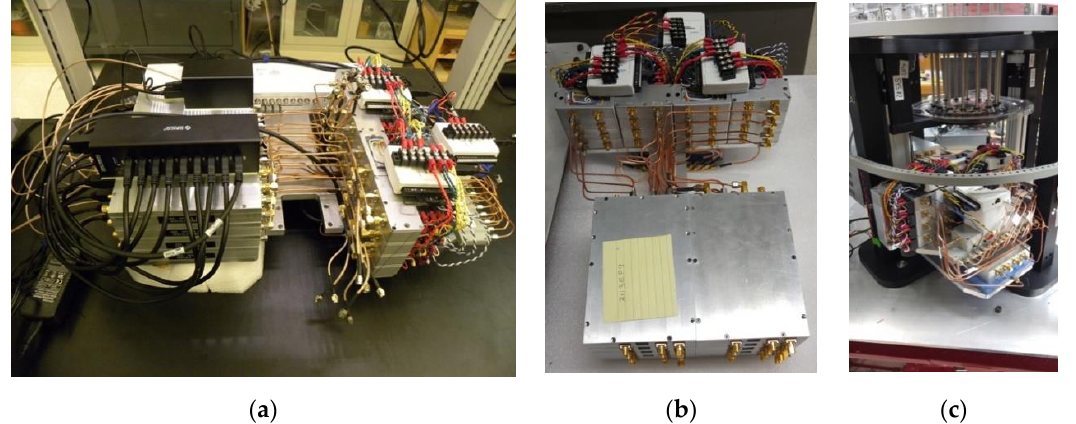
Figure 6. Photographs of the microwave electronic subsystem showing: ( a ) a complete system fully assembled external to the imaging system, ( b ) electronics with the grouping of eight shielded B210s (bottom) and switch / amplifier modules (top; USB hubs removed to expose componentry), respectively, and ( c ) a complete system integrated below the imaging tank and supported by the antenna array mounting